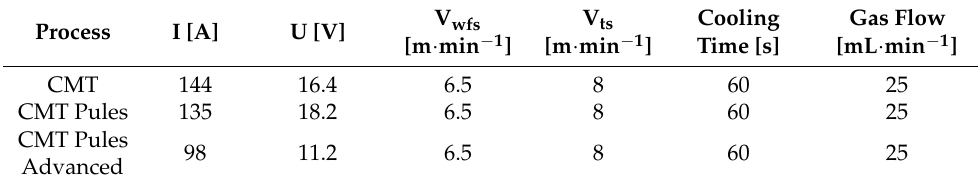
Figure 2. ( a ) Deposition system setup and ( b ) schematic diagram showing the sampling position. Table 2. Deposition